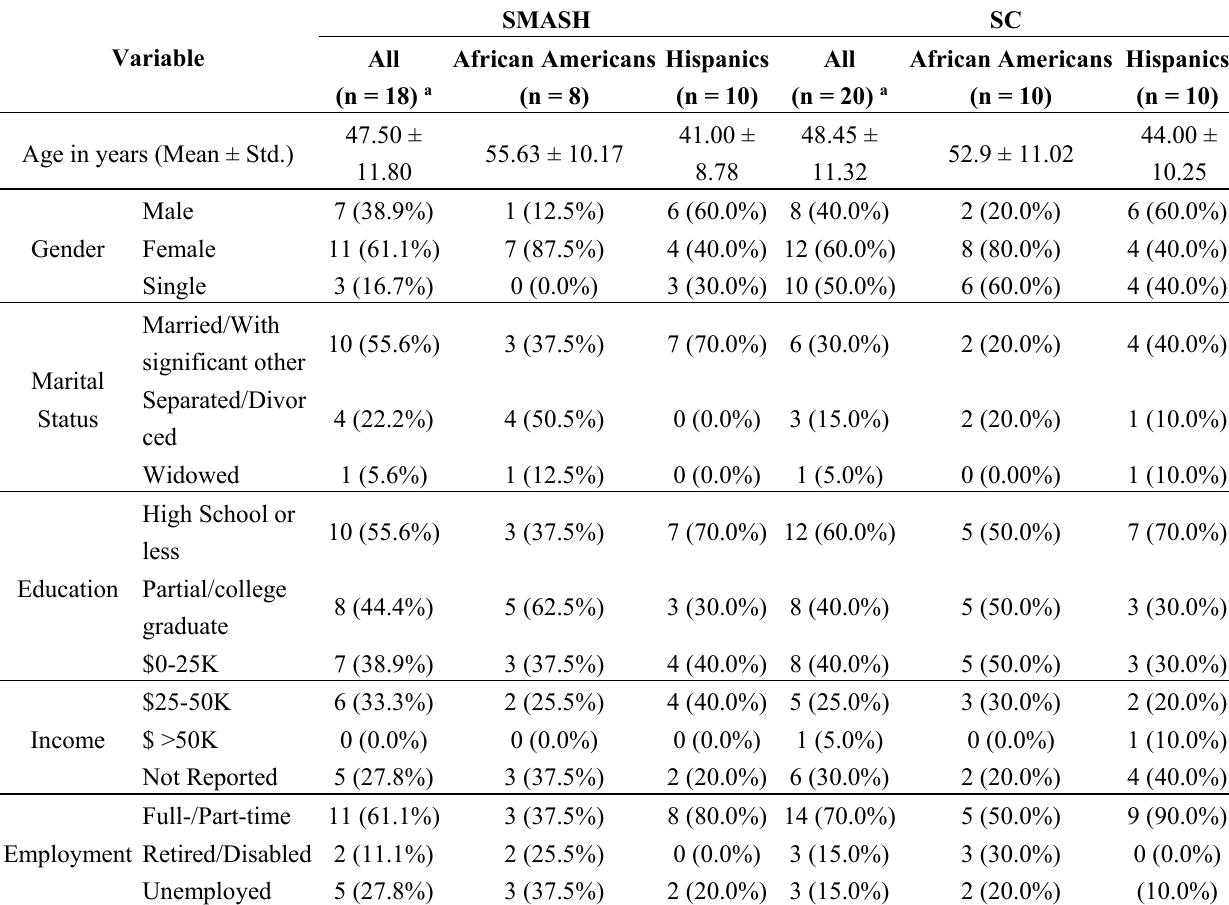
Table 1. Descriptive characteristics of